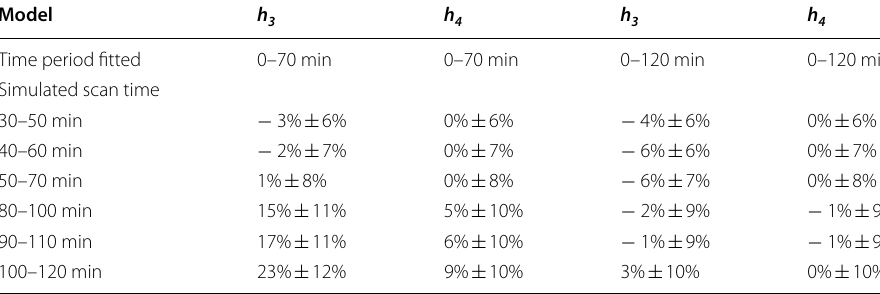
Values are mean SD ( N 20). The last column shows parameters for the reference PBIF that produced lowest errors. Each ± = row represents the results for each different simulated 20 min D‑WB PET scan start time